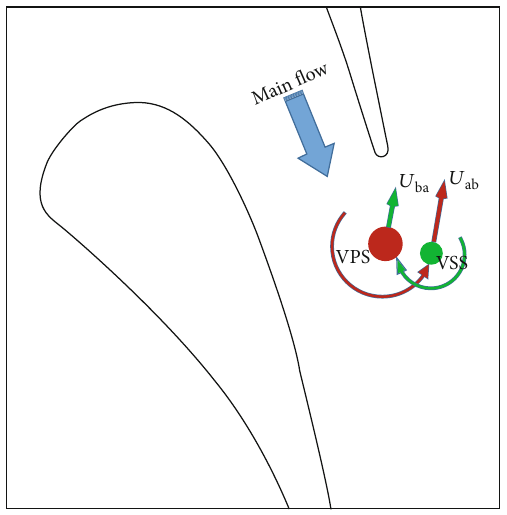
Figure 10: Double-vortex structure in a vortex pair.